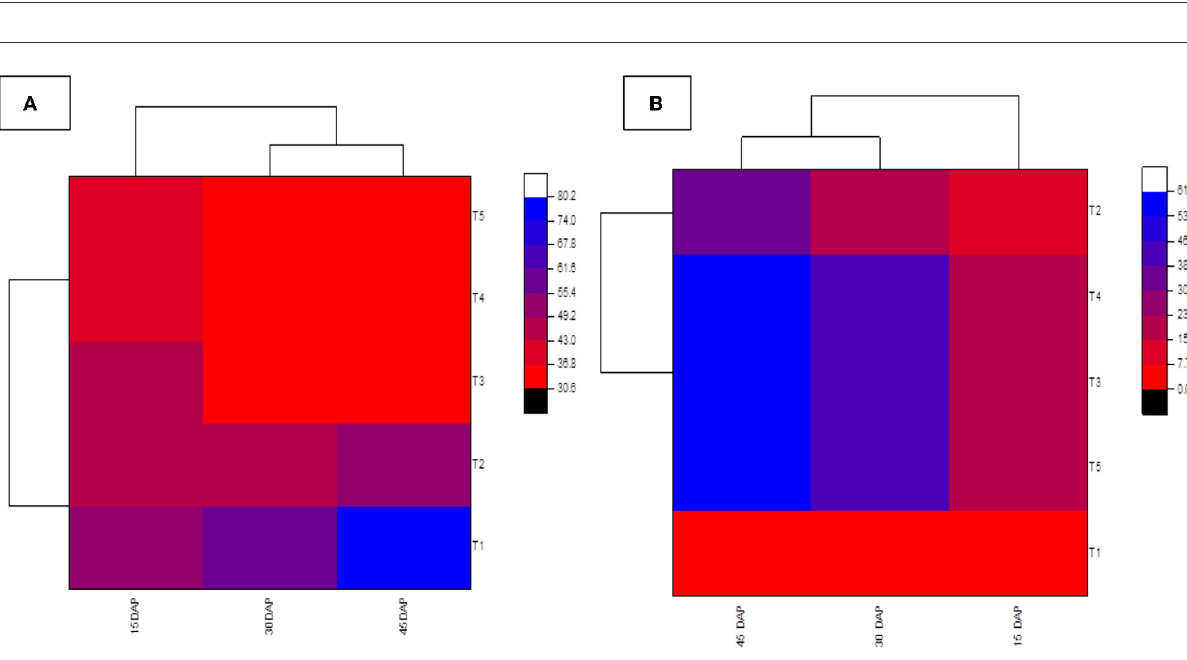
FIGURE13 Heatmap showing (A) disease incidence and (B) disease reduction in Ag NP-treated tomato plants against early blight of tomato in the field. The results were obtained at 15, 30, and 45 dapi. A commercial fungicide, mancozeb (1,000 ppm), was used as a positive control. Ag NP treatments were T1 (control), T2 (10 ppm), T3 (20 ppm), T4 (40 ppm), and T5